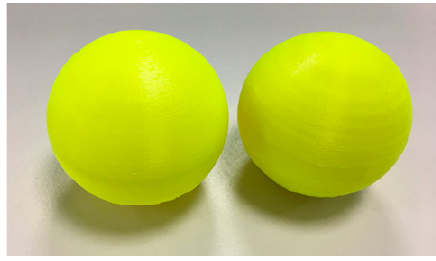
Figure 7. Printed balls with the normal condition ( left ) and the faulty joint bearing A ( right ).